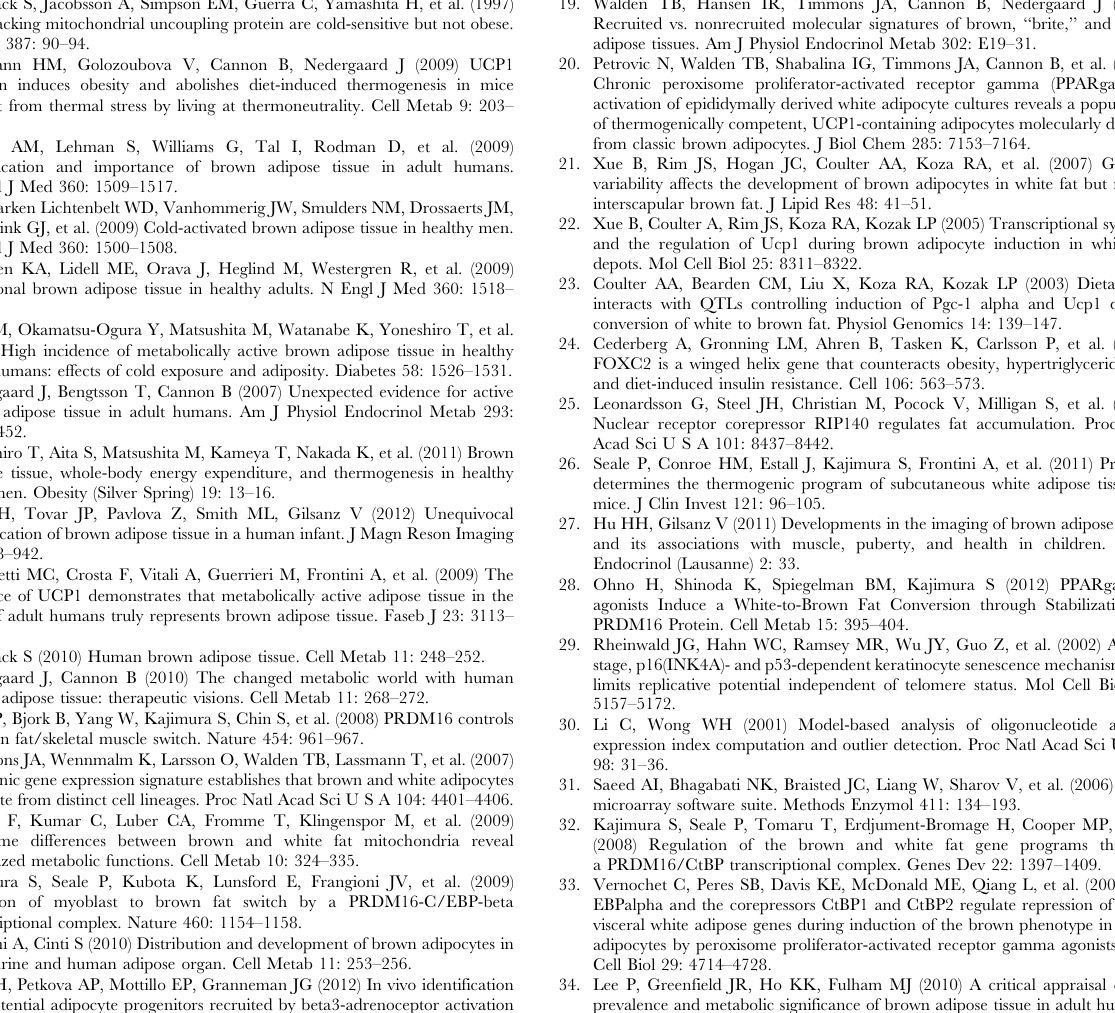
Figure 4. Expression of a new beige cell marker CITED1 in mice and in humans. ( A ) Immunohistochemistry of UCP1 (left) and CITED1 (right) in serial sections of WAT in mice that were treated with CL316243 at a dose of 1 mg/kg (upper panels) or saline control (lower panels) for 8 days . Scale bar, 50 m m. ( B ) Immunohistochemistry of UCP1 (left) and CITED1 (right) in serial sections of human BAT. Lower panels show IgG negative controls of immunohistochemistry for UCP1 (Cy3) and for CITED1 (FITC), respectively in human BAT. Scale bar, 50 m